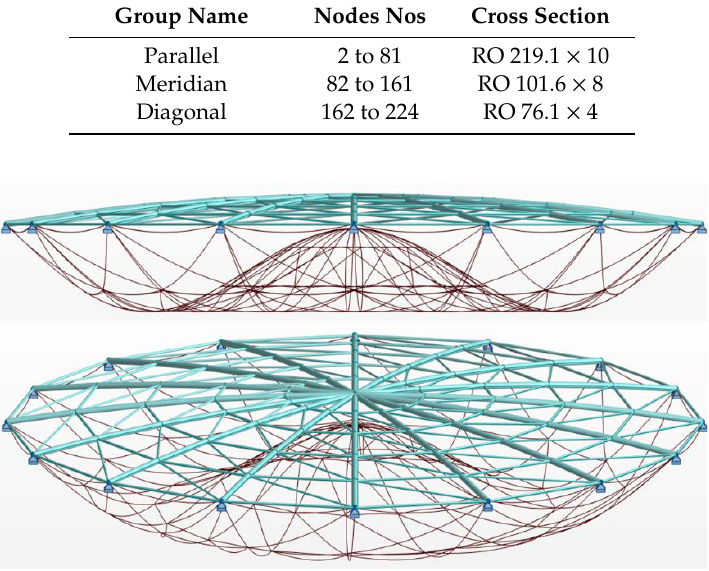
Figure 16. Ribbed dome deformation. Table 8. Values of the internal forces and the maximum horizontal and vertical displacement of node 79 for LA.